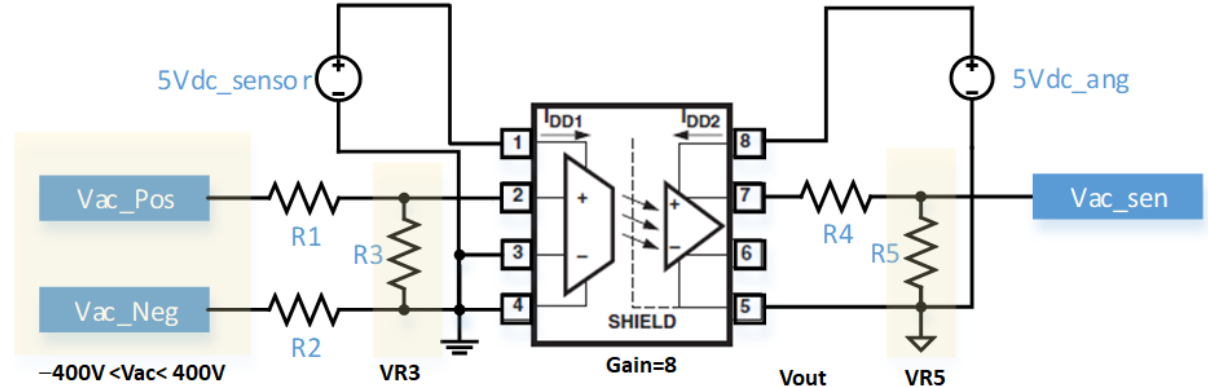
Figure 4. Schematic of the designed online AC voltage measurements circuit.